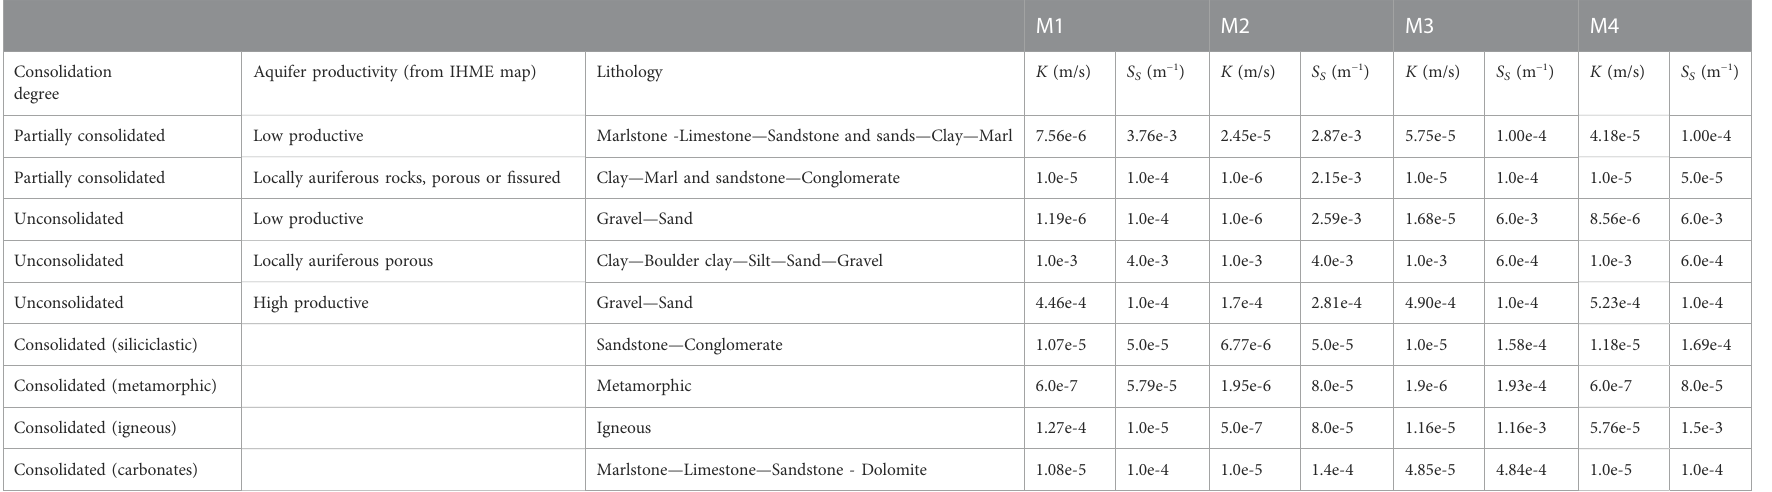
TABLE 3 Calibrated hydraulic parameters with the transient